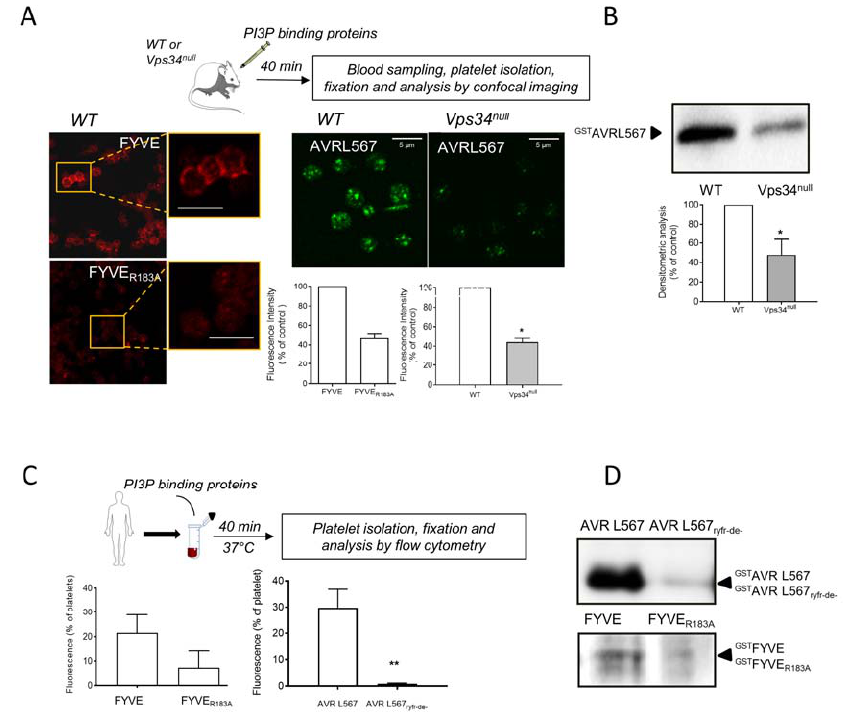
Figure 6. Interaction of PI3P-binding domains with platelets in vivo and ex vivo. The FYVE probe and its mutant FYVE R183A (25 µ g/mL, in red) were injected into the blood circulation in WT mice ( A ). The AVR L567 probe (100 µ g/mL, in green) was also injected into the blood circulation of WT and Vps34-deficient megakaryocyte/platelet (Vps34 null ) mice. Blood was collected 40 min post-injection and platelets were isolated and fixed before fluorescence analysis by confocal imaging ( A ). The images shown are representative of 3 independent experiments. Scale bar: 5 µ m. The fluorescence intensity per platelet (n = 300) was quantified using the ImageJ software (( A ), lower panels) and the results are expressed as a percentage of control (FYVE probe fluorescence in WT mice or the AVR L567 fluorescence in WT mice for Vps34 null mice). In addition, platelets collected after injection of the AVR L567 probe were also activated in vitro in HEPES buffer with Collagen Related Peptide (CRP, 1 µ g/mL), and the secretome of activated platelets was collected by centrifugation to analyze the presence of the AVR L567 probes by Western blotting with an anti-GST antibody ( B ). A representative image of the Western blotting from 3 independent experiments is shown. The relative band intensity was quantified using the Image Lab 6.1.0.7-2 software (Bio-Rad) and results are expressed as a percentage of control (AVR L567 band intensity in WT mice platelet secretome). The FYVE and AVR L567 probes and their inactive mutants were added to freshly collected human blood and after 40 min at 37 ◦ C, platelet-rich plasma was obtained by centrifugation. After dilution in a 10-fold volume of HEPES buffer, platelets were collected by centrifugation and fluorescence was analyzed by flow cytometry ( C ). The results are presented as the percentage of fluorescent platelets, with the mean ± SEM calculated from 3 independent experiments. Additionally, the collected platelets were activated in vitro in HEPES buffer with Collagen Related Peptide (CRP, 1 µ g/mL) and their secretome was then harvested by centrifugation and analyzed using Western blotting with an anti-GST antibody ( D ). A representative image from 3 independent experiments is presented. Wilcoxon test compared the different conditions to control ( A , B ) or FYVE and AVR L567 ( C ), * p ≤ 0.05, ** p ≤